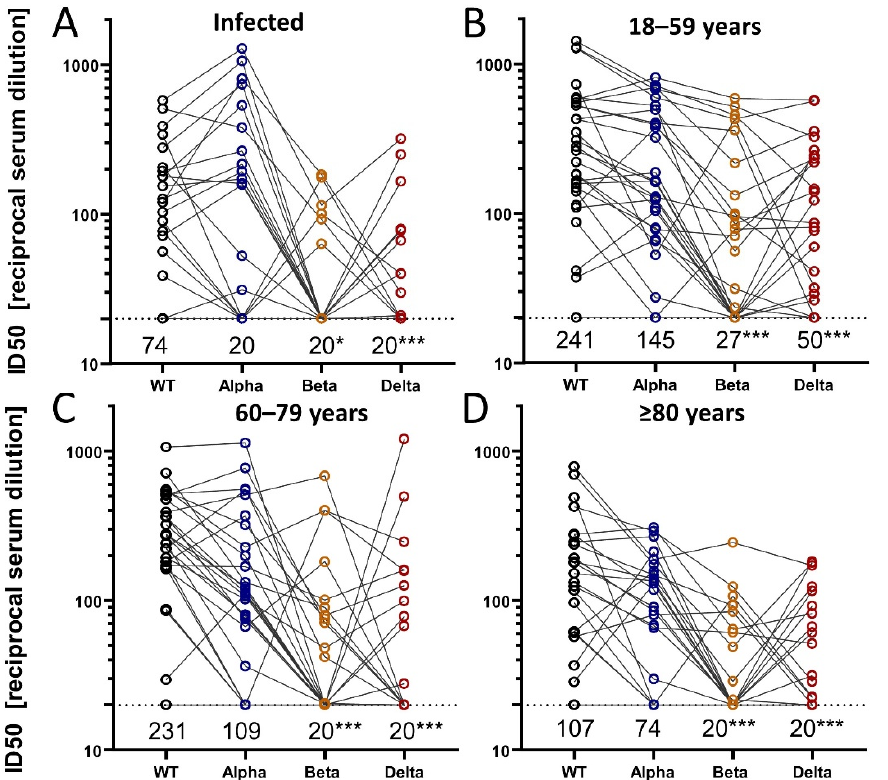
Figure 4. Breadth of neutralization after infection or vaccination. We randomly selected four groups of participants totaling n = 120 (30 infected and unvaccinated ( A ), 90 vaccinated twice with Comirnaty from three age groups ( B – D )). The neutralization activity was determined in a lentiviral pseudotype assay using the spike proteins of wild type (D614G) SARS-CoV-2 and the indicated VOCs. Shown are the reciprocal of the 50% inhibitory dilution (ID 50 ) of each serum sample by WT or VOCs. Person- specific measurements for WT and VOCs are connected by gray lines. Dashed black lines indicate the lower limit of detection (ID 50 = 20) and median ID 50 values per group are stated below this line. We conducted paired tests (Wilcoxon rank-sum test) comparing VOCs with WT and indicate significant differences in the medians by *, *** for p -values of <0.01 and <0.0001,